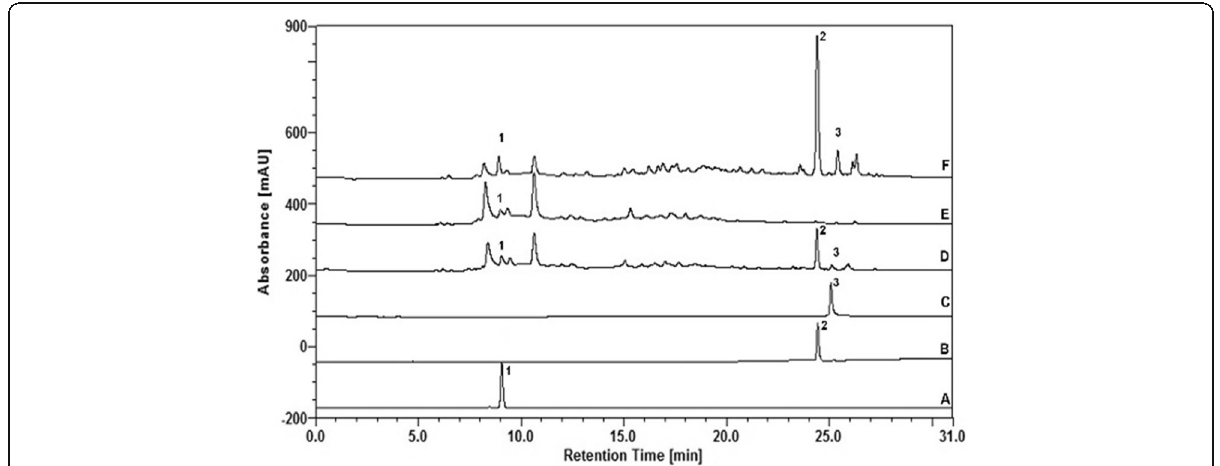
Fig. 1 Chromatographic profiles of Gallic acid (A), Myricitrin (B), Ellagic acid (C), CE (D), AqF (E), and EAF (F) of E. uniflora Linn leaves as determined by HPLC. CE: crude extract, AqF: aqueous fraction, EAF: ethyl acetate-treated fraction. The retention times (RT) for gallic acid, myricitrin and ellagic acid of these substances were 8.7 min (peak 1), 23.3 min (peak 2), and 25.1 min (peak